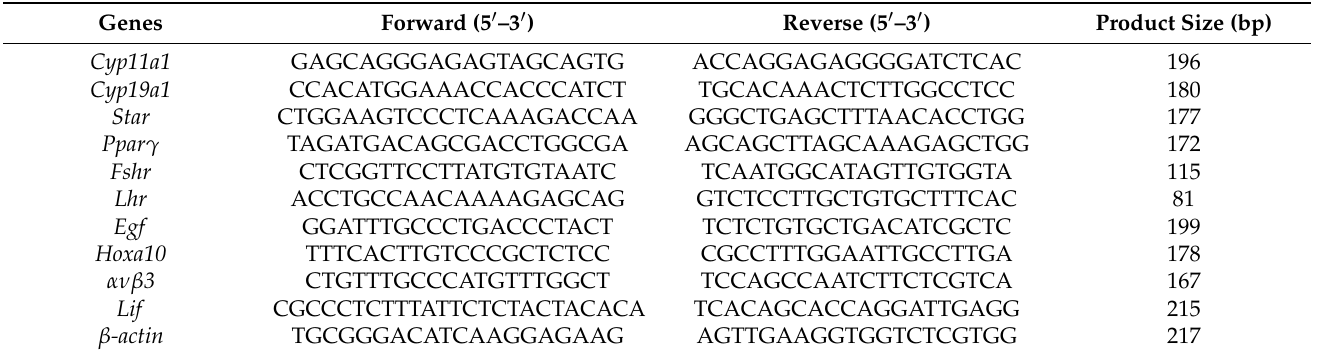
Table 1. Primers (pig) used for